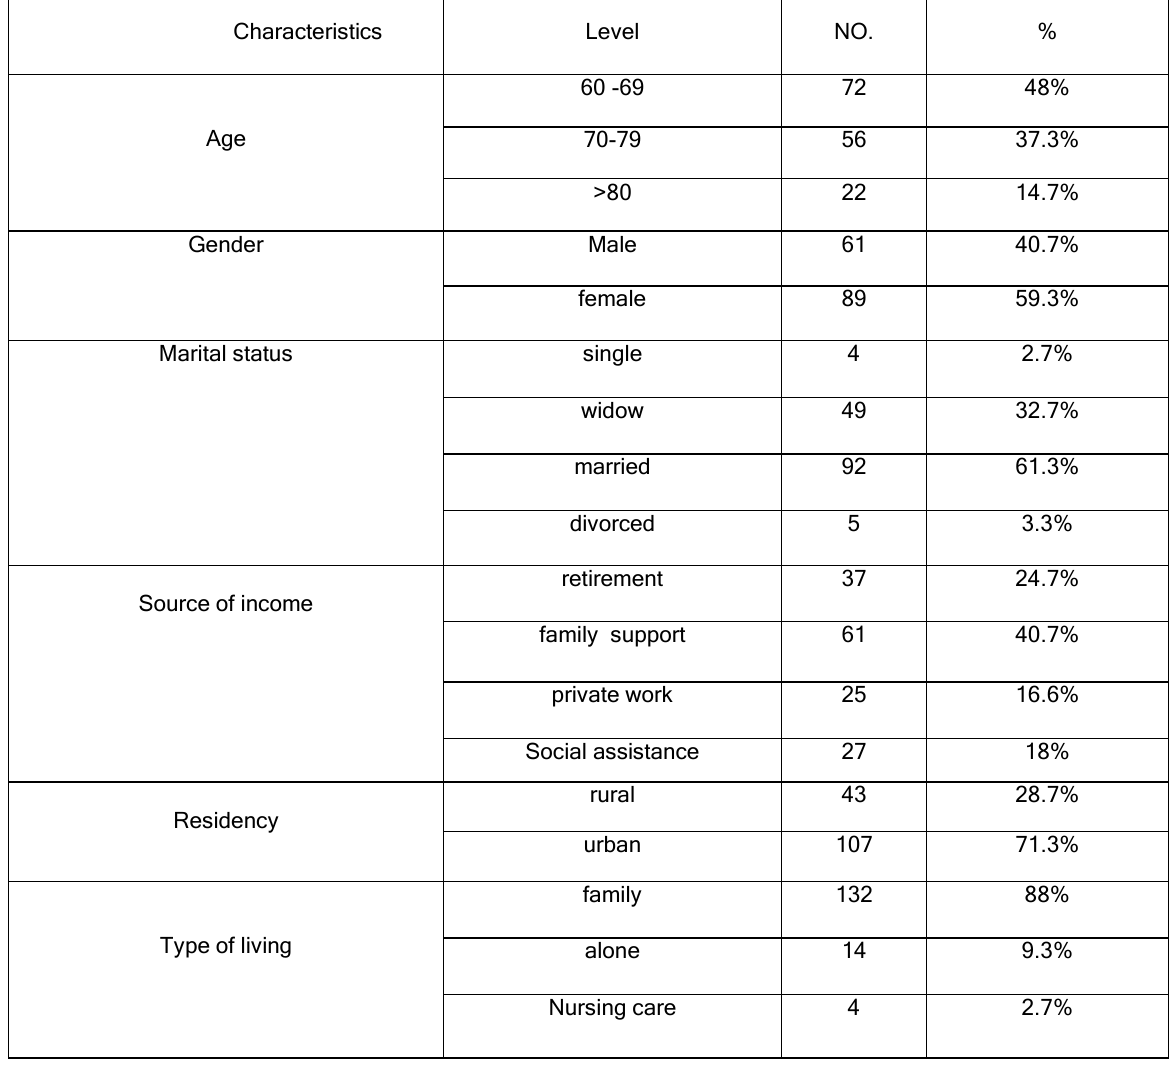
Table(1)showing the demographic characteristic of the studied